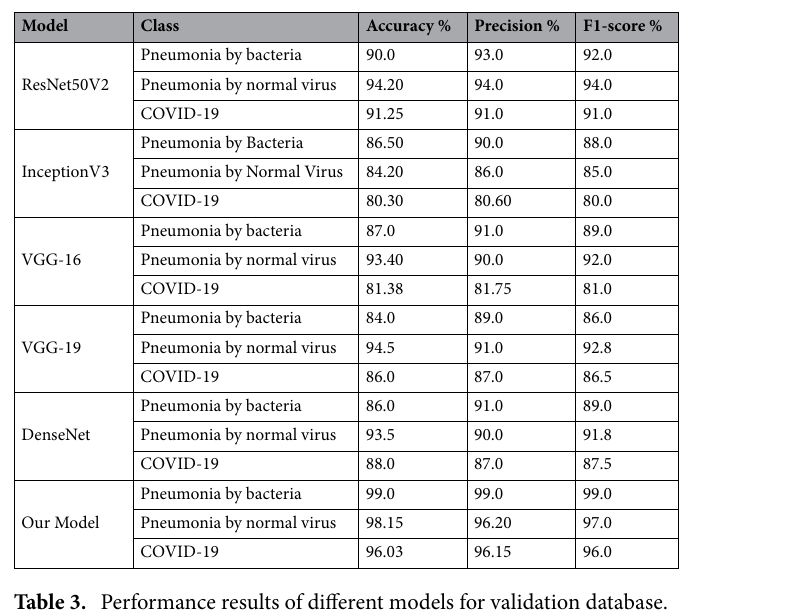
Table 3. Performance results of different models for validation